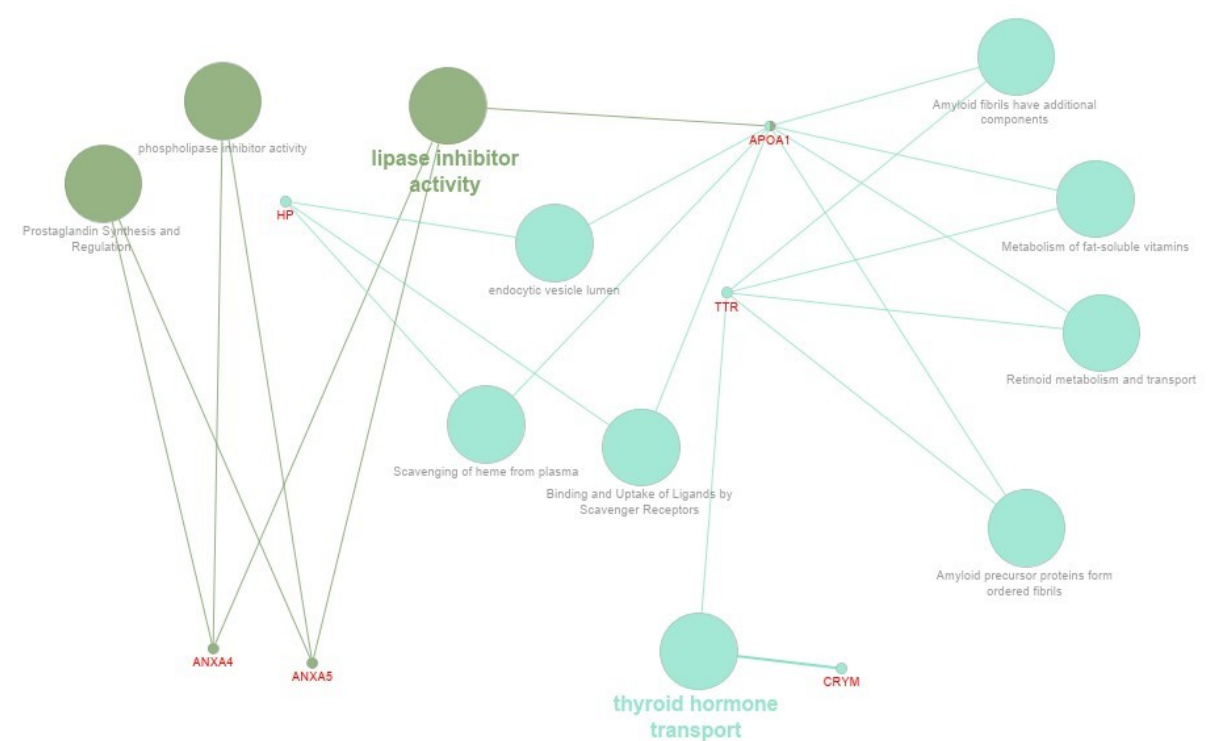
Figure 5. Visualisation of the functionally grouped gene ontology and protein interaction networks of DEPs in porcine en- dometrium. Comparison of the preimplantation (9D) and peri-implantation period (16D) of pregnancy based on pathway’s enrichment significance analysis by Cytoscape ClueGo TM . The nodes’ size reflects the pathway’s enrichment significance.